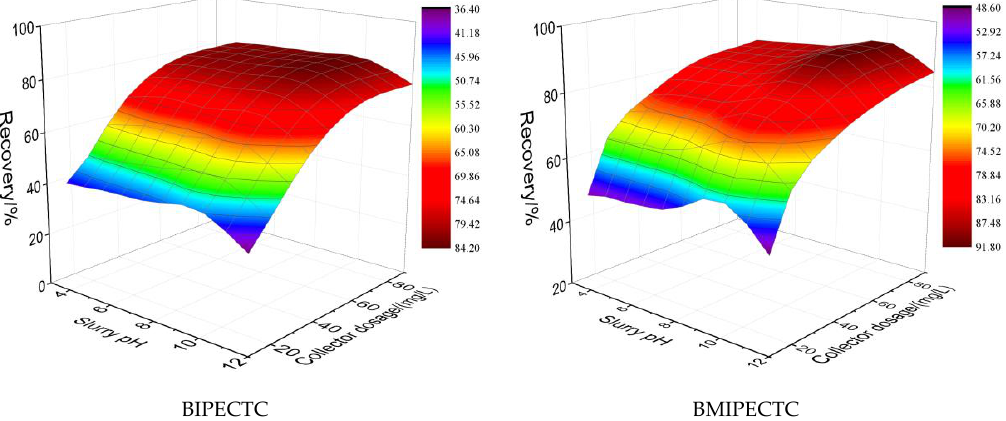
Figure 7. Recovery response surface plots with both the slurry pH and collector dosage.